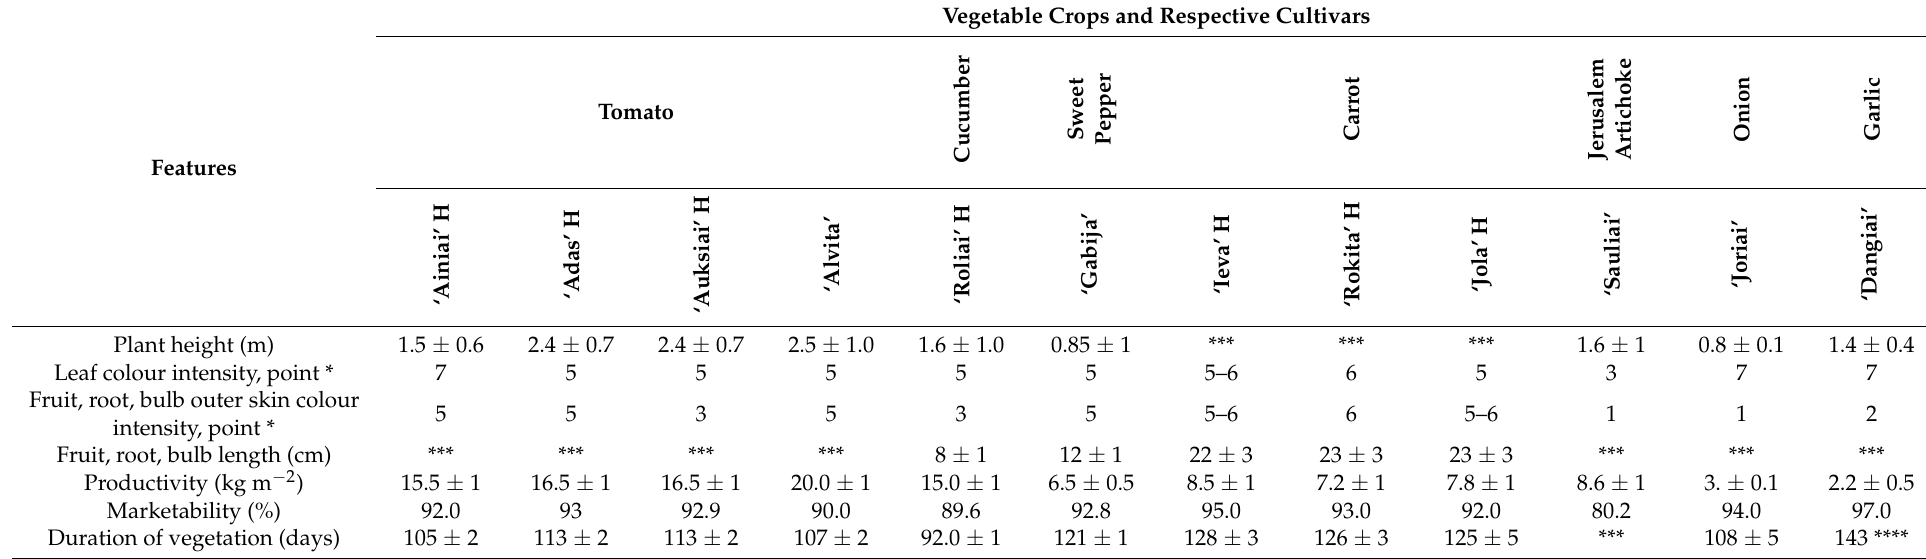
Table 8. Agrobiological features of newly created vegetable